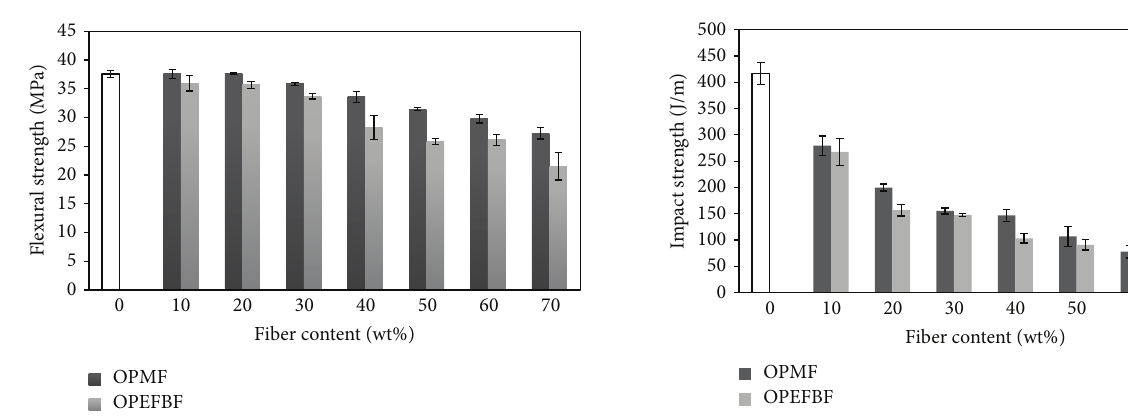
Figure 2: Flexural strength of PBS, PBS/OPMF and PBS/OPEFBF biocomposites.